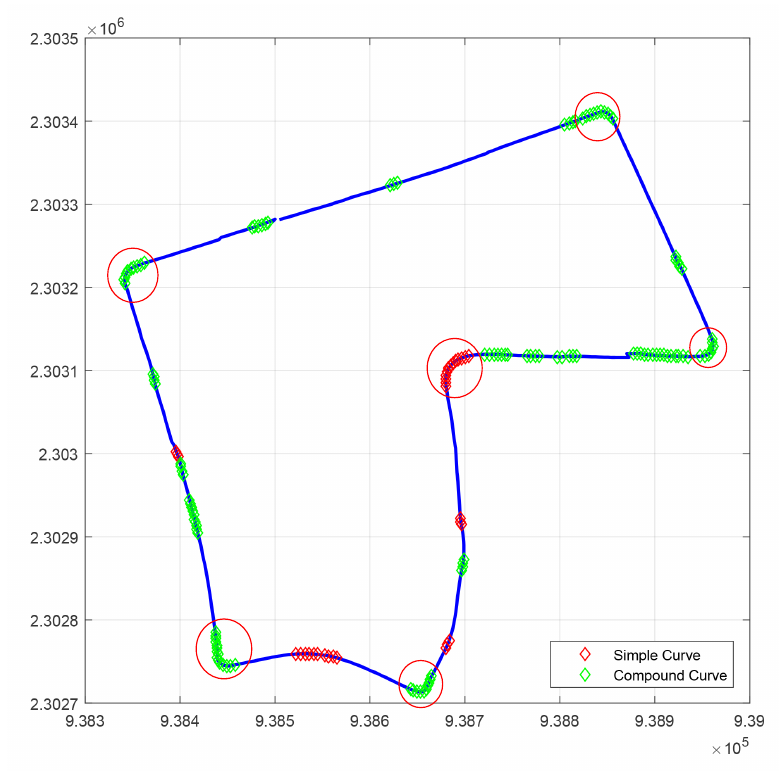
Figure 6. Curve classification of UTBM-2 dataset (see Section 5 for reference). Sharp curves are marked with red circles.